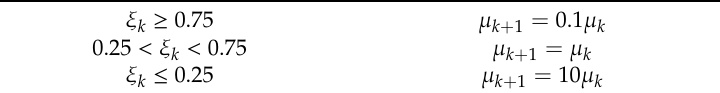
Table 1. Update rule for parameter µ